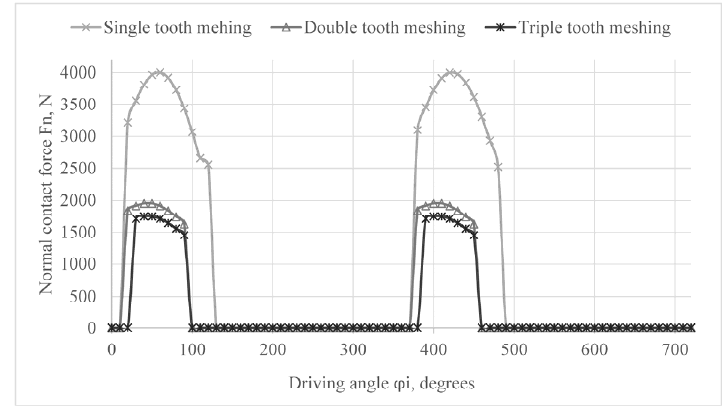
Figure 3. Diagram of the normal contact force.